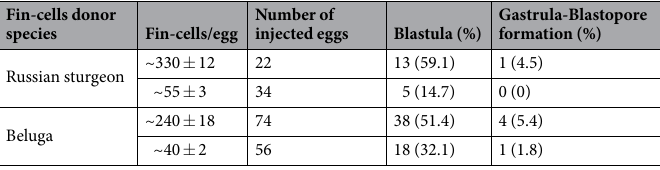
Table 1. Comparison of mNTs developmental rate after different number of fin cells from Russian sturgeon or beluga were injected into sterlet